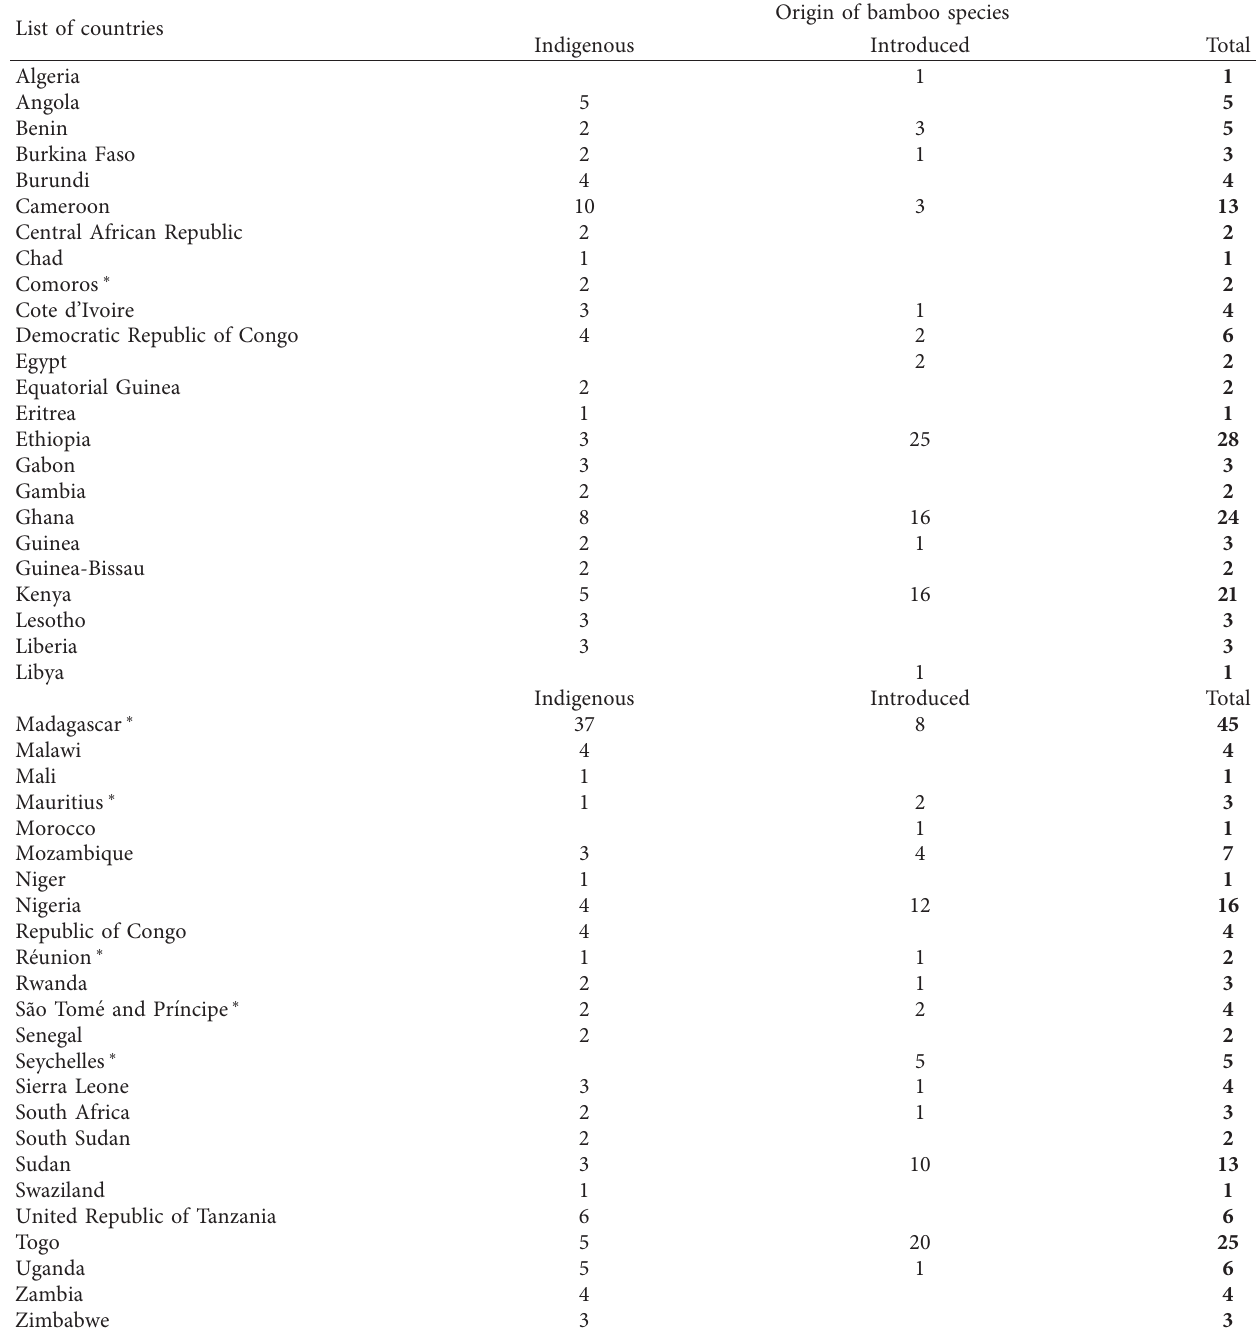
Table 5: A summary of the origin and distribution of bamboo resource in the African